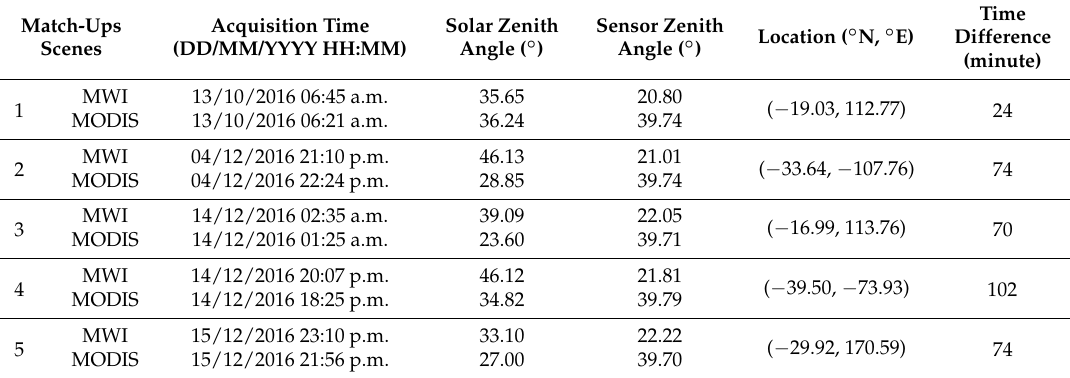
Table 5. Acquisition times, imaging geometries and locations of MWI and MODIS match-ups for